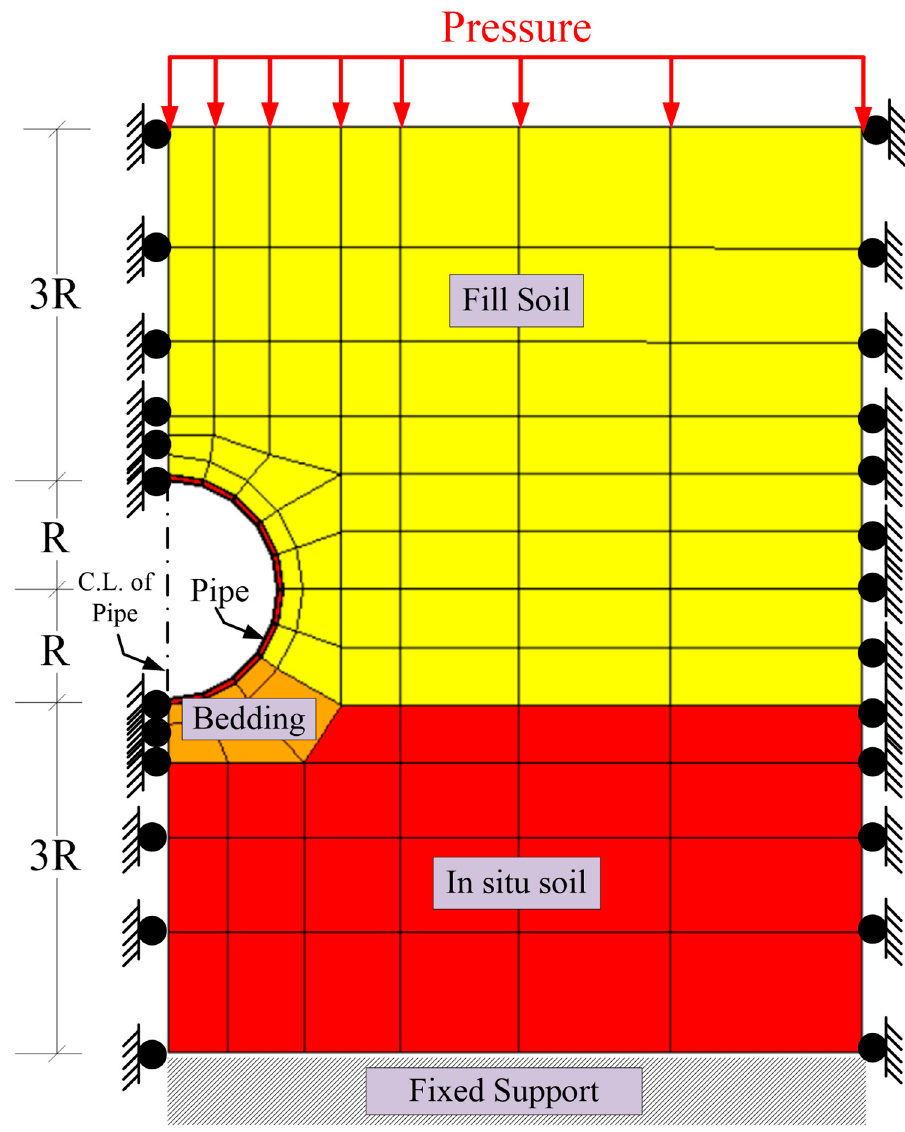
Figure 3. FEA model soil layers, boundary conditions, and loading pressure. In contrast, the left and right sides of the model were restrained in the horizontal direction only because the model was symmetric at the pipeline’s centerline. The FEA